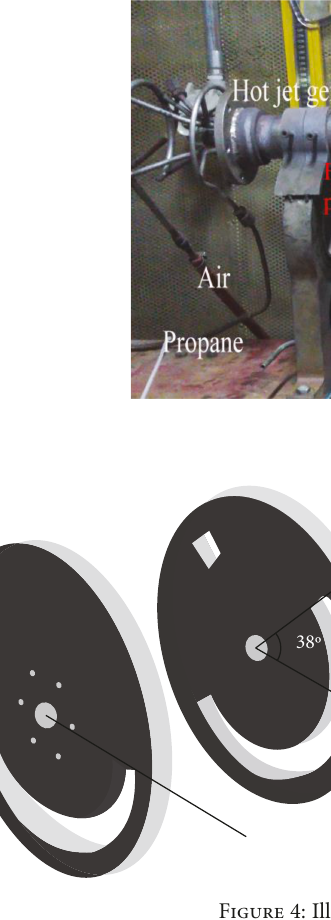
Figure 4: Illustration of the sealing disk structure on both sides of a